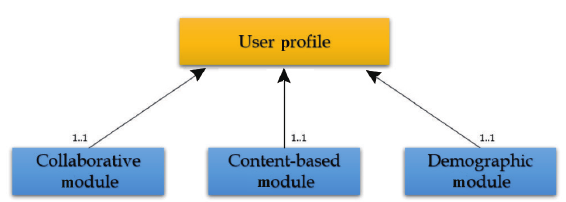
Fig. 3 User profiling, where 1.1 represents that the user profile contains one and only one of each